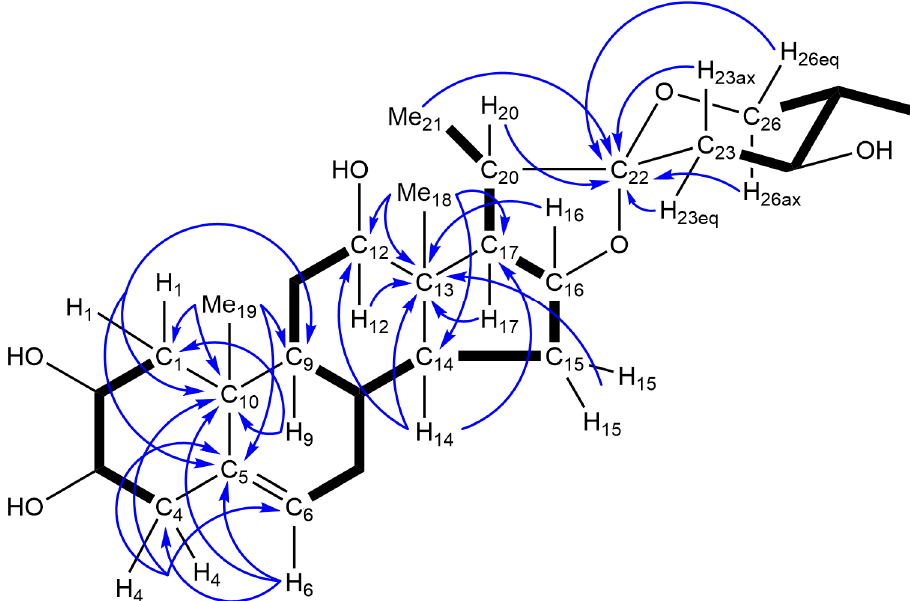
Figure 2. HMBC and 1 H- 1 H spin-coupling correlations of 1a . Bold lines indicate the 1 H- 1 H spin couplings traced by 1 H- 1 H COSY spectrum and arrows indicate 1 H/ 13 C long-range correlations observed in the HMBC spectrum.